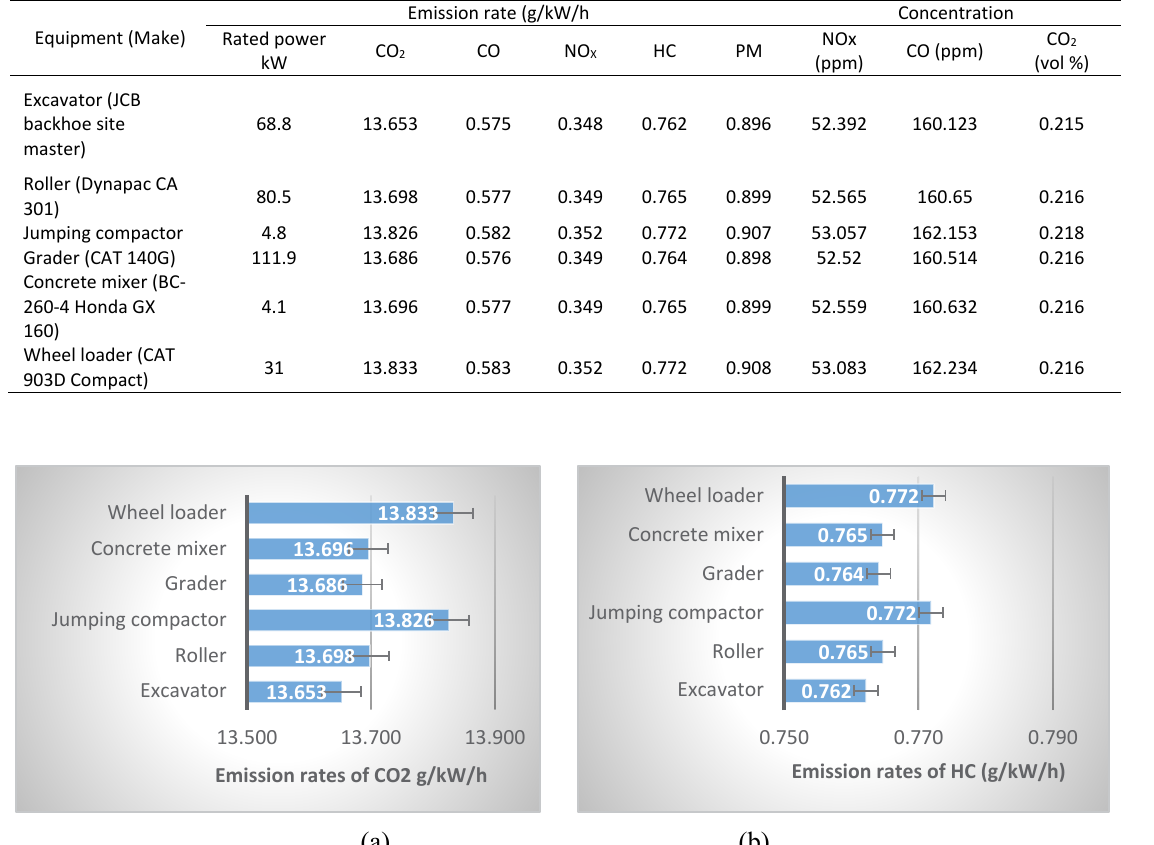
Table 2: Estimated modelled emission rates of the sampled construction equipment